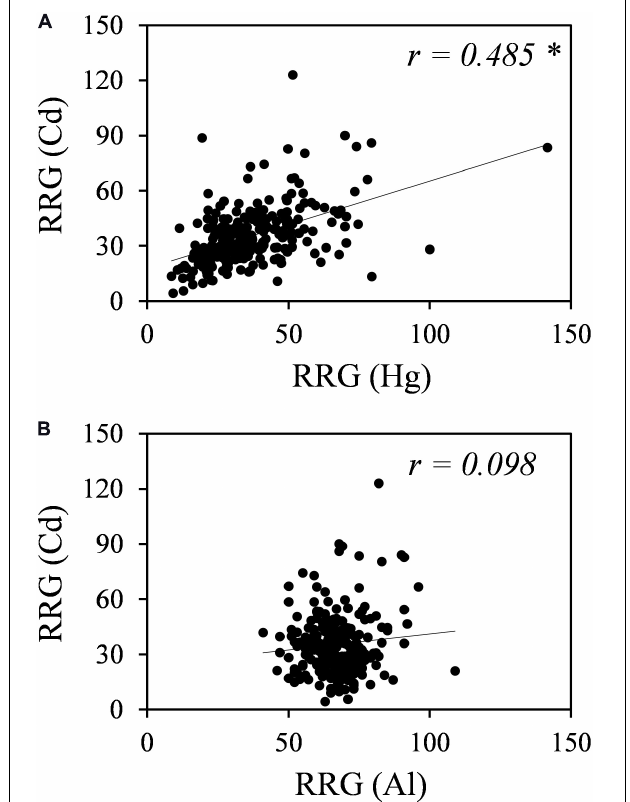
FIGURE 2 | Correlation analyses for Cd and Hg tolerances (A) and for Cd and Al tolerances (B) . RRG values for Hg were obtained from García de la Torre et al. (2013), and RRG values for Al were obtained from Sledge et al. (2005). * Indicates significant correlation at p -value <